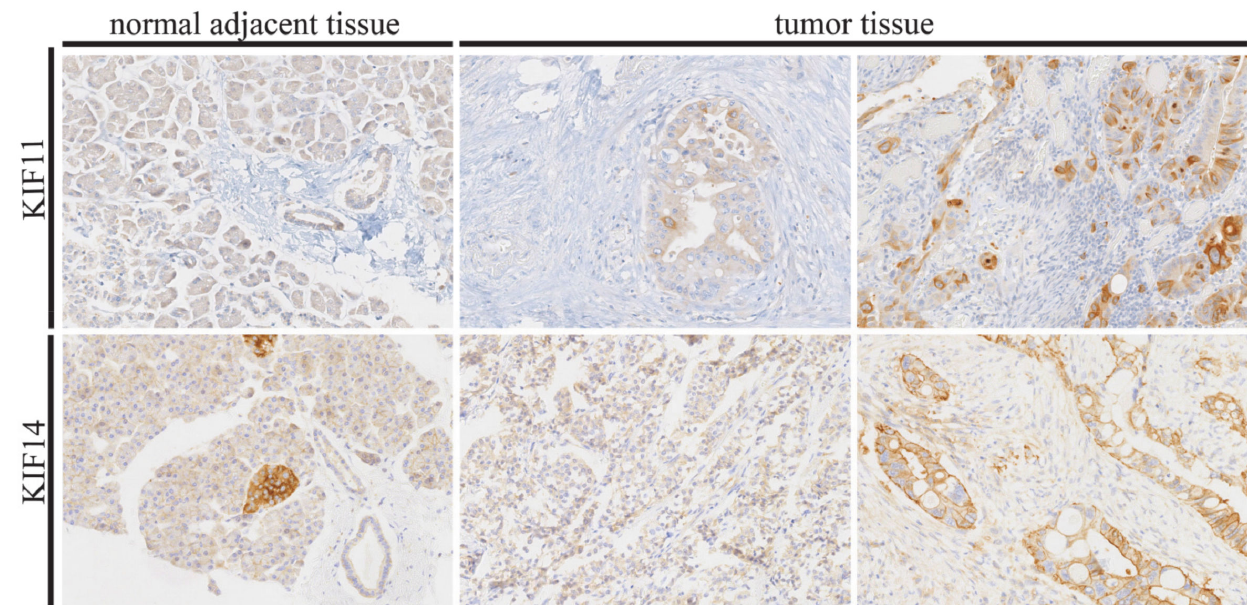
Figure 1. Representative images of immunohistochemical expression of KIF11 and KIF14 in pancreatic ductal adenocarci- noma and normal adjacent tissue (control). In tumor tissues, low expression (left images) and high expression (right images) of the studied proteins can be seen. Original magnification 20 ×